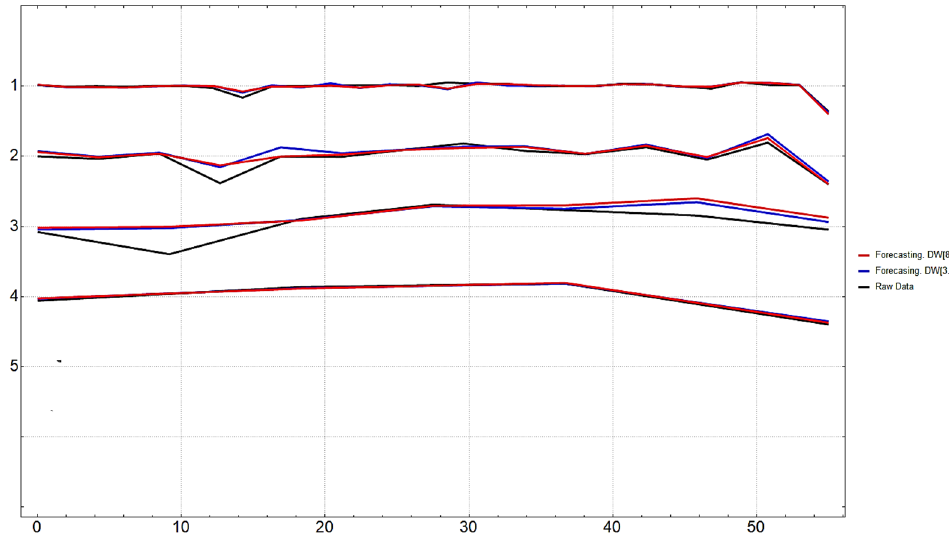
Figure 9. Variance chart plots for the first four components after the DWT-based decomposition: